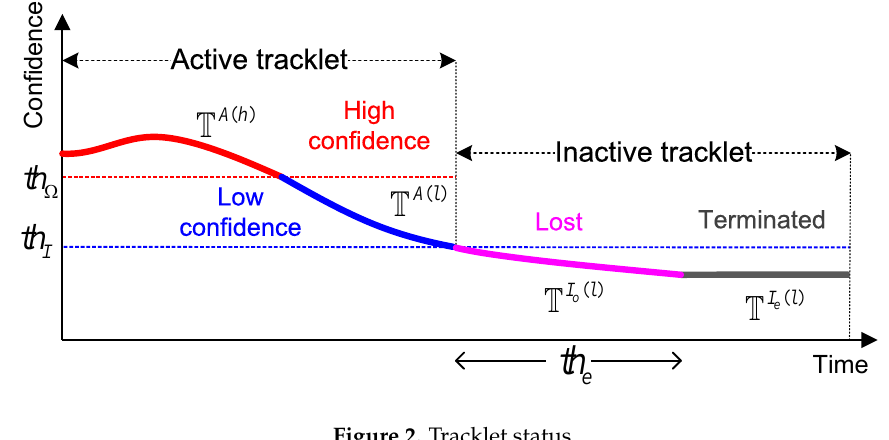
Figure 2. Tracklet